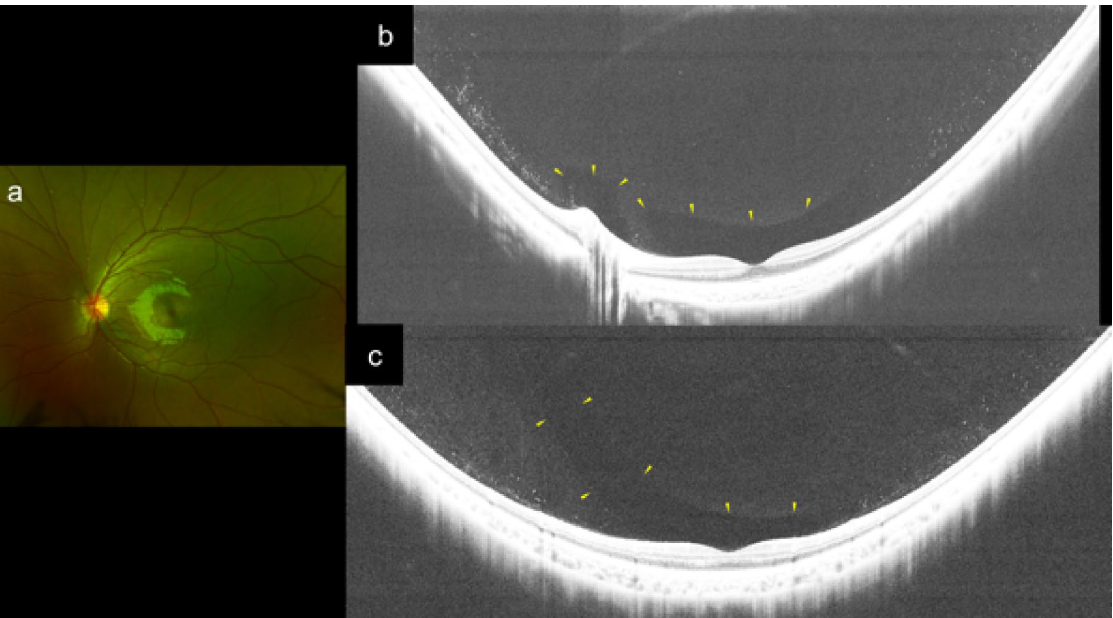
Figure 1. Findings in the posterior vitreous of an 8-year-old boy with moderate myopia and a refractive error of − 3.75 diopters and an axial length of 25.16 mm. ( a ) Fundus photograph of the left eye. ( b ) Brightened horizontal UWF OCT image showing that Cloguet’s canal and precortical posterior vitreous pocket (PPVP) are present above the inner retinal surface (yellow arrowheads) and medium reflective granular opacities are present in posterior vitreous cortex. ( c ) Brightened vertical UWF-OCT image showing that the superior edge of the PPVP extends anteriorly (yellow Posterior vitreous detachment and paravascular retinoschisis in non‑highly myopic and highly myopic children. None of the 24 eyes of the non-HM children had a partial PVD. The posterior vitreous had a Cloquet’s canal and the precortical posterior vitreous pockets were seen as hyporeflective spaces in these non-HM eyes (Fig. 1). Among the 27 eyes of HM children, partial PVDs were seen in 2 eyes (7.4%). Of these 2 eyes, one HM eye had medium-reflective tissues located between the detached vitreous and inner retinal surface (Fig. 2). The posterior vitreal surface had a relatively higher reflectivity and was thicker than that in the other areas around the site where this bridging tissue attached to the posterior vitreous (Fig. 2). A myopic RS was seen at the paravascular area in one HM eye (4%), but not in the non-HM eyes (Table 2). Posterior vitreous detachment in highly myopic adolescents. Partial PVDs were seen in 4 of the 22 eyes (18%) among the HM adolescents. In these 4 eyes, medium-reflective tissues were present on the relatively